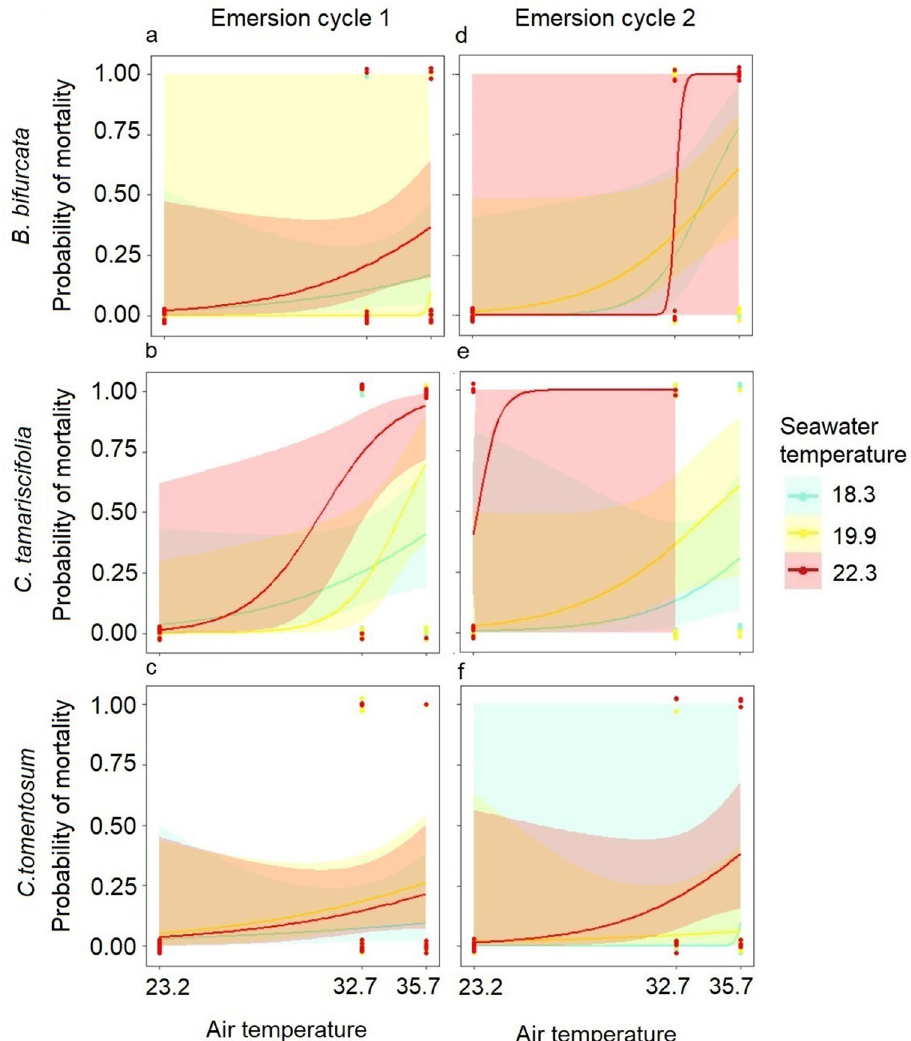
Figure 2. Mortality probability in relation to air and seawater temperature after each emersion cycle in the laboratory experiment. Curves are fitted by GLMs with a binomial error structure and a confidence interval of 95%. Dots indicate binary mortality observations in each treatment (air temperature, control ~ 23.2 °C, atmospheric heatwave ~ 32.7 °C and extreme atmospheric heatwave ~ 35.7 °C), (seawater temperature, control ~ 18.3 °C, marine heatwave ~ 19.9 °C and extreme marine heatwave ~ 22.3